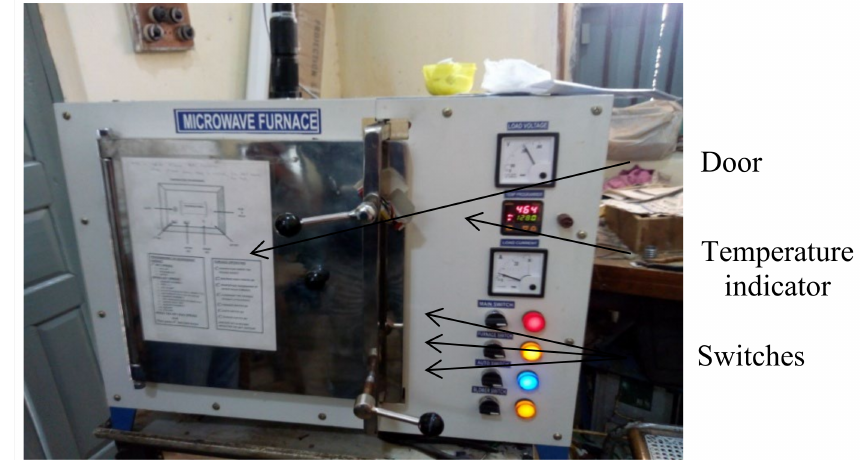
Figure 8. Microwave furnace setup.